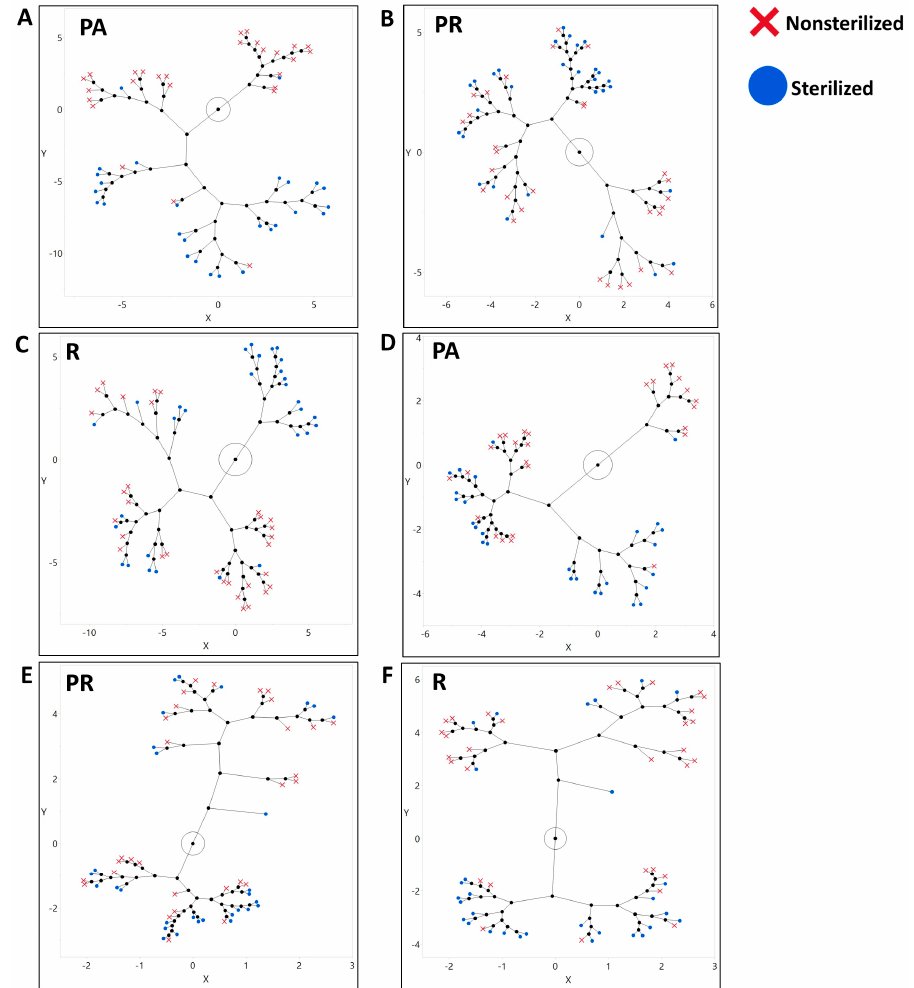
Figure 4. Inheriting parental bacteria influences the formation of larvae symbiotic bacterial community with the effect being unequal among the diets. ( A – C ) Bray–Curtis distances between NS and S larvae raised on PA, PR, and R diets, respectively. NS and S communities are clearly separated on ( A ) PA and ( C ) R diets, and ( B ) PR food is less distinct. ( D – F ) Weighted Unifrac distances. Larvae raised on ( A ) PA and ( C ) R diets form more distinct communities than larvae raised on ( B ) PR